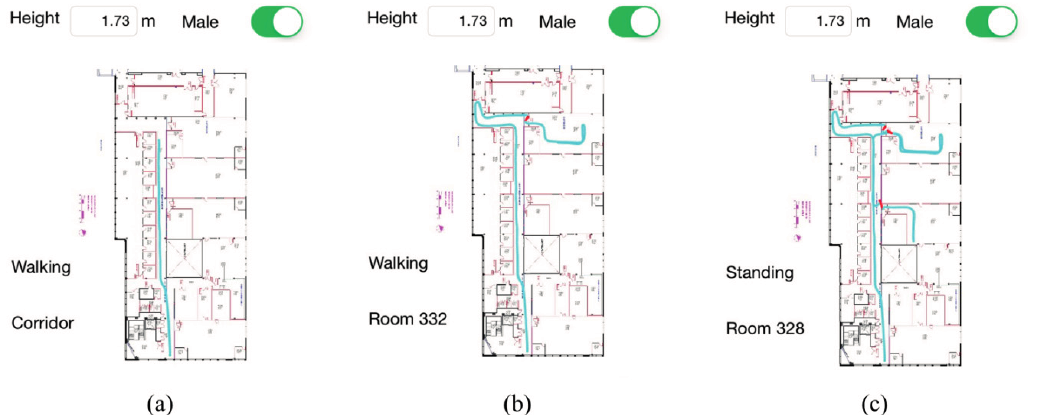
Figure 11. Intermediate tracking results during the long-term experiment ( a ) Walking in corridor ( b ) Walking in room 332 ( c ) Standing in room 328.